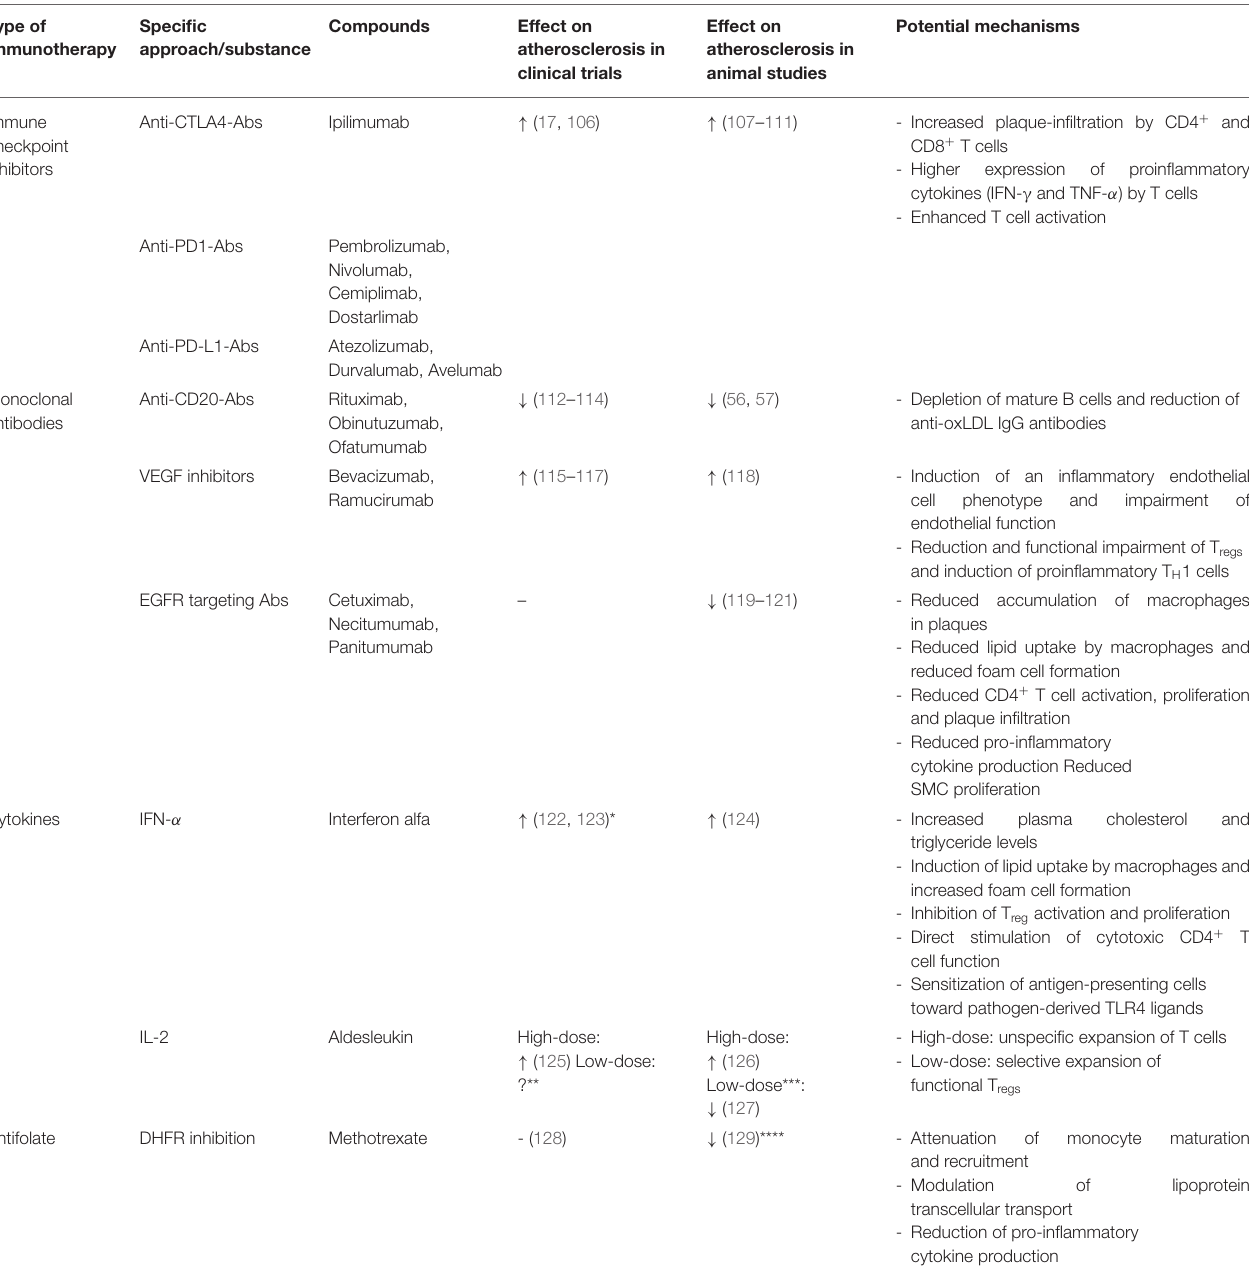
TABLE 1 | Pro-atherogenic and athero-protective effects of current cancer immunotherapies. Type of Specific immunotherapy approach/substance